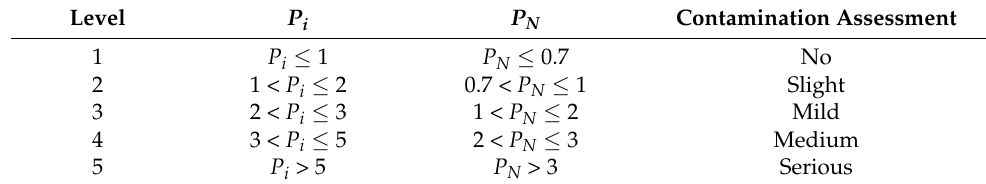
Table 3. The classification of the contamination degree according to the value of P i and P N